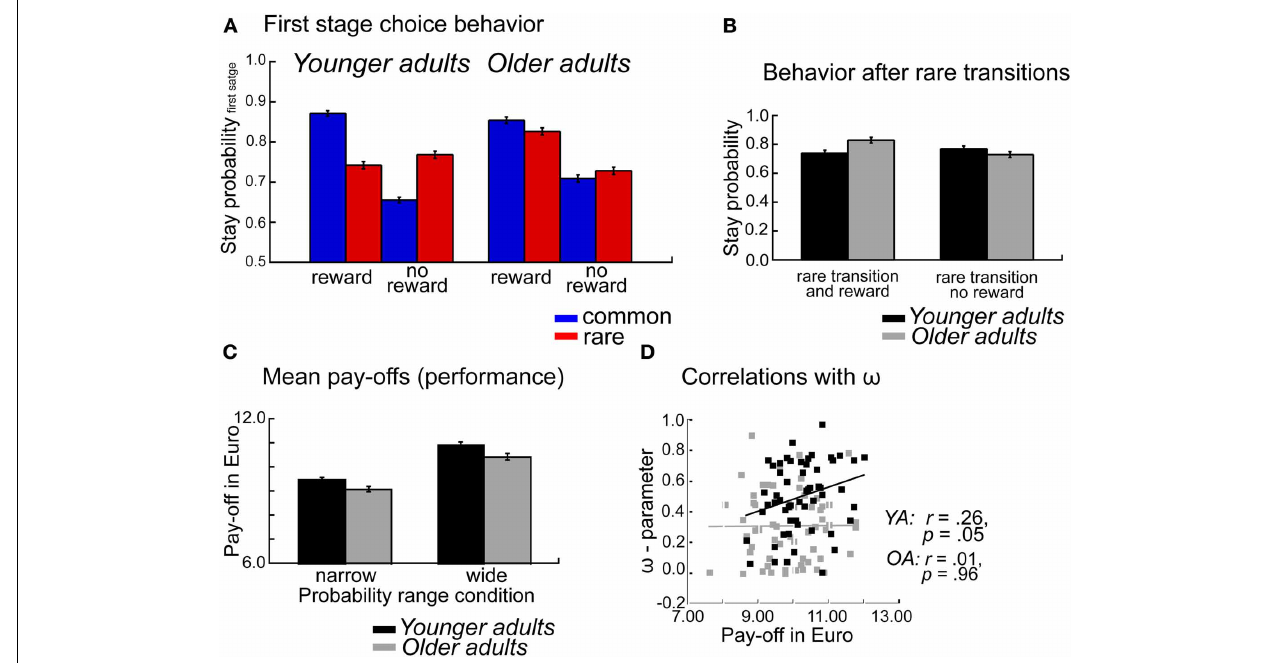
FIGURE 2 | (A) Probability of repeating the same first stage choice as a function of the transition on the previous trials (common, rare transition) and the outcome received on the previous trial (reward, no reward). Stay probabilities are displayed separately for younger adults (left panel) and older adults (right panel), error bars reflect the standard error of the mean (s.e.m.).